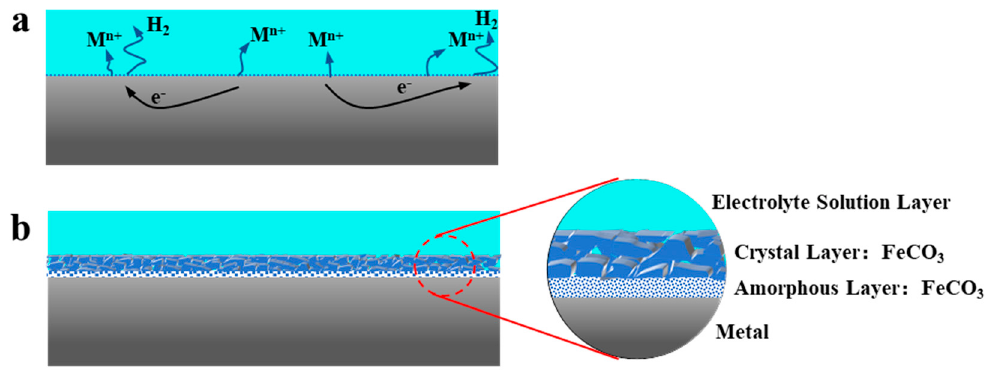
Figure 12. Schematic of Mesa corrosion mechanism of N80 steel under high temperature and high CO 2 partial pressure: ( a ) Uniform corrosion stage; ( b ) Corrosion product deposition stage;